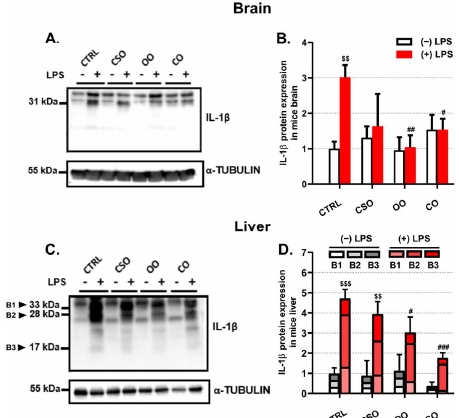
Figure 2. Effect of cactus seed oil, olive oil, or colza oil treatment on protein expression of the proinflammatory marker Il-1 β ( A – D ), in the brain ( A , B ) and liver ( C , D ), respectively. Male C57BL/6 mice received for 28 days a standard diet (control (CTRL)), a diet enriched with 6% ( w / w ) CSO, OO, or CO, and intravenous injection of LPS (100 µ g) four hours antemortem. Brain and liver homogenates were separated in PAGE-SDS electrophoresis and subjected to immunoblotting as described in Material and Methods section. Immunoblots were performed in triplicate and here we showed a representative blot. The three processed Il-1 β bands (B1: 33 kDa; B2: 28 kDa; B3:17 kDa) intensities were analyzed by densitometry and standardized to α -tubulin (55 kDa) expression level in brain ( B ) and in liver ( D ). All values are means ± SD (n = 3) of 3 independent replicates. Statistical significance of higher mean signal strength compared to control, (### p ≤ 0.01. ## p ≤ 0.01. # p ≤ 0.05) compared to LPS, and ($$$ p ≤ 0.001. $$ p ≤ 0.01) compared to the different treatments with or without LPS administration. Statistics were executed using two-way ANOVA followed by Tukey test for multiple